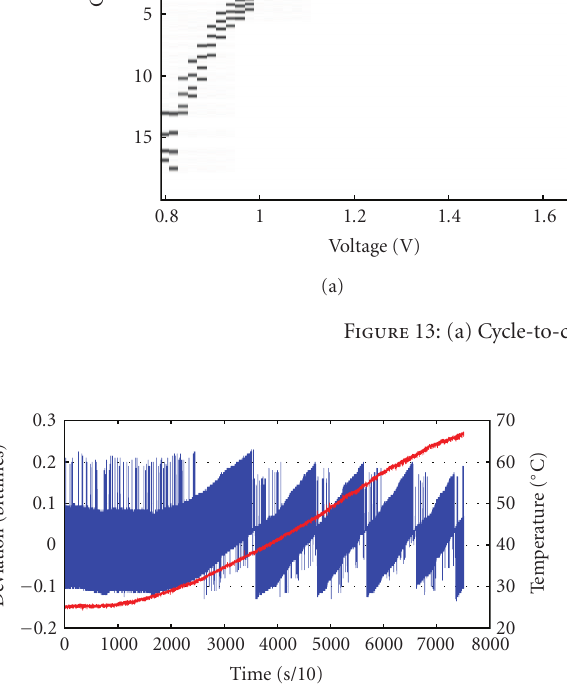
Figure 14: Relative deviation from optimal sending slot and operating temperature.